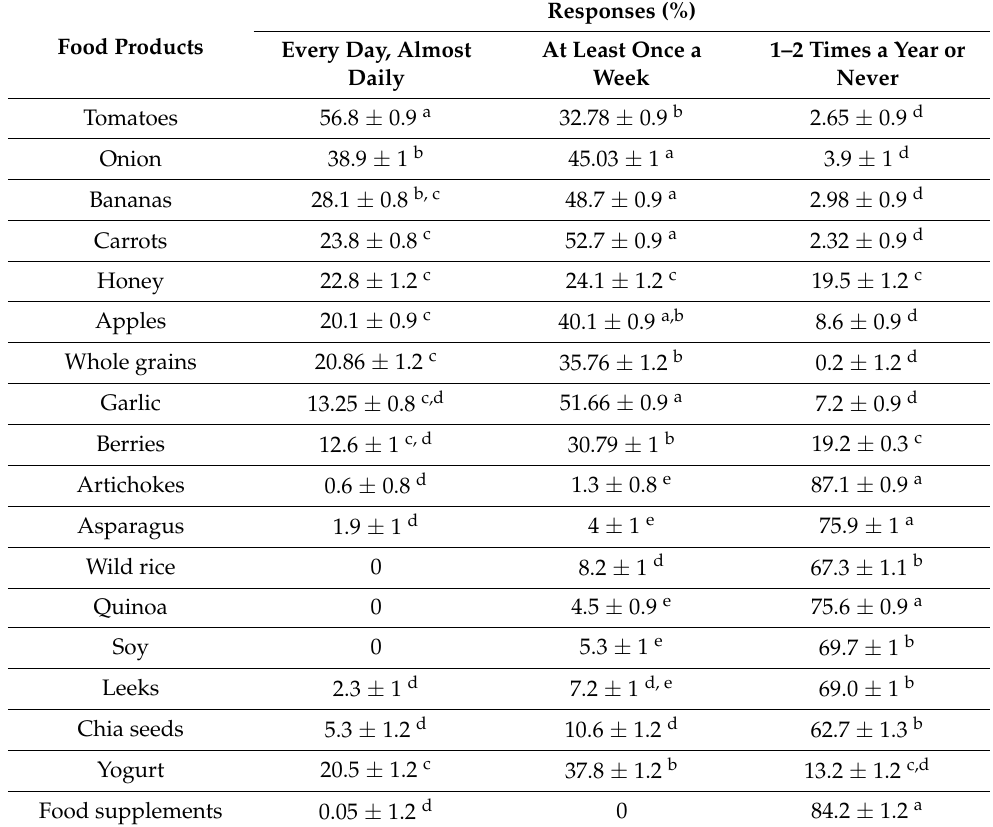
Table 2. Frequency of consumption of certain food